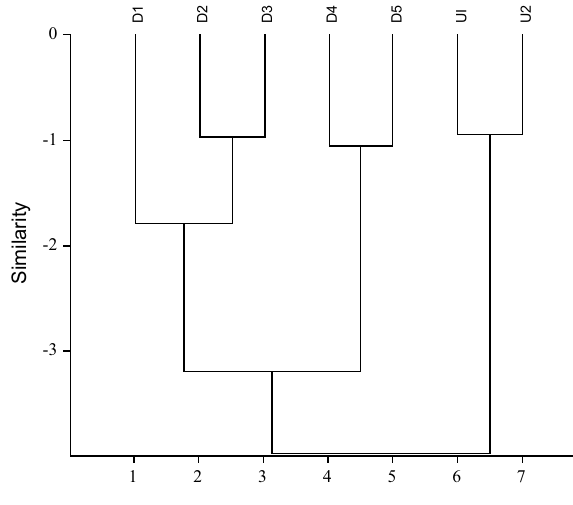
Fig. 3 Hierarchical cluster analysis showing the association among metal concentrations of upstream (U) and downstream (D) sampling